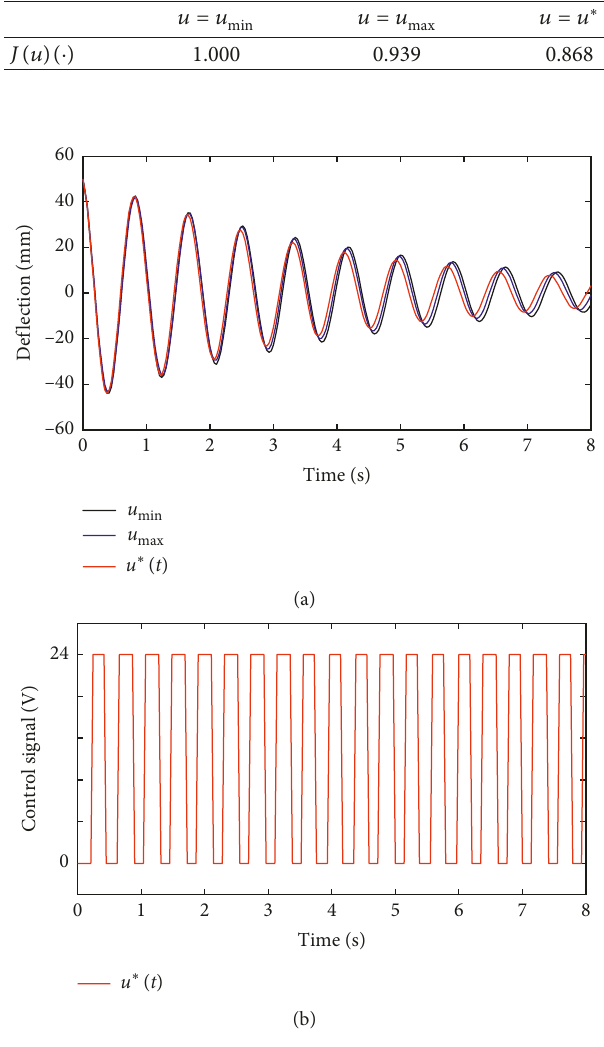
Figure 20: The trajectories of the tip deflection in the passive and the switched control cases (a) and switched control signal